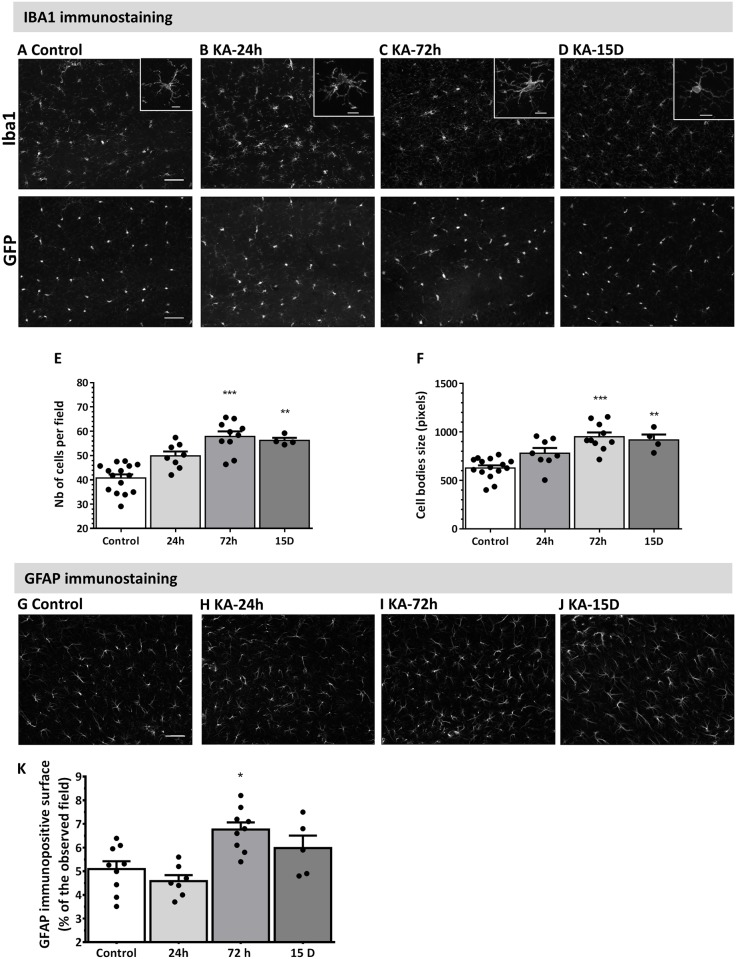
Time-dependent microgliosis and astrogliosis following IN KA induced seizures.Analysis performed in mice experiencing stage 5 or higher. A-D) Representative images of IBA1 immunostaining (upper panels) and GFP fluorescence (C57BL6/J CX3CR1+/eGFP mice; lower panels) in CA1 region in control mice (A), and 24h (B), 72h (C) and 15 days (D) after IN KA. Scale bar = 50 μm. Insets depict enlarged image of individual microglial cells. Scale bar = 10 μm E-F) Quantitative analysis of IBA1 immunostaining in the hippocampus 24h, 72h and 15 days after IN KA-induced SE shows significant microglial activation, including increased cell number and size. G-I) Representative images of GFAP immunostaining in CA1 region in control mice (G), 72h (H) and 15 days (I) after IN KA. Scale bar = 20 μm. J) Quantitative analysis of GFAP immunostaining in the hippocampus shows astrogliosis 72h after IN KA. Results are represented as mean ± SEM (n ≥ 6 per group). Statistical analysis was performed using a non-parametric Kruskal-Wallis one-way analysis of variance followed by Dunn’s post-test. *: p<0.05; **: p<0.01; ***: p<0.001 compared to control condition.